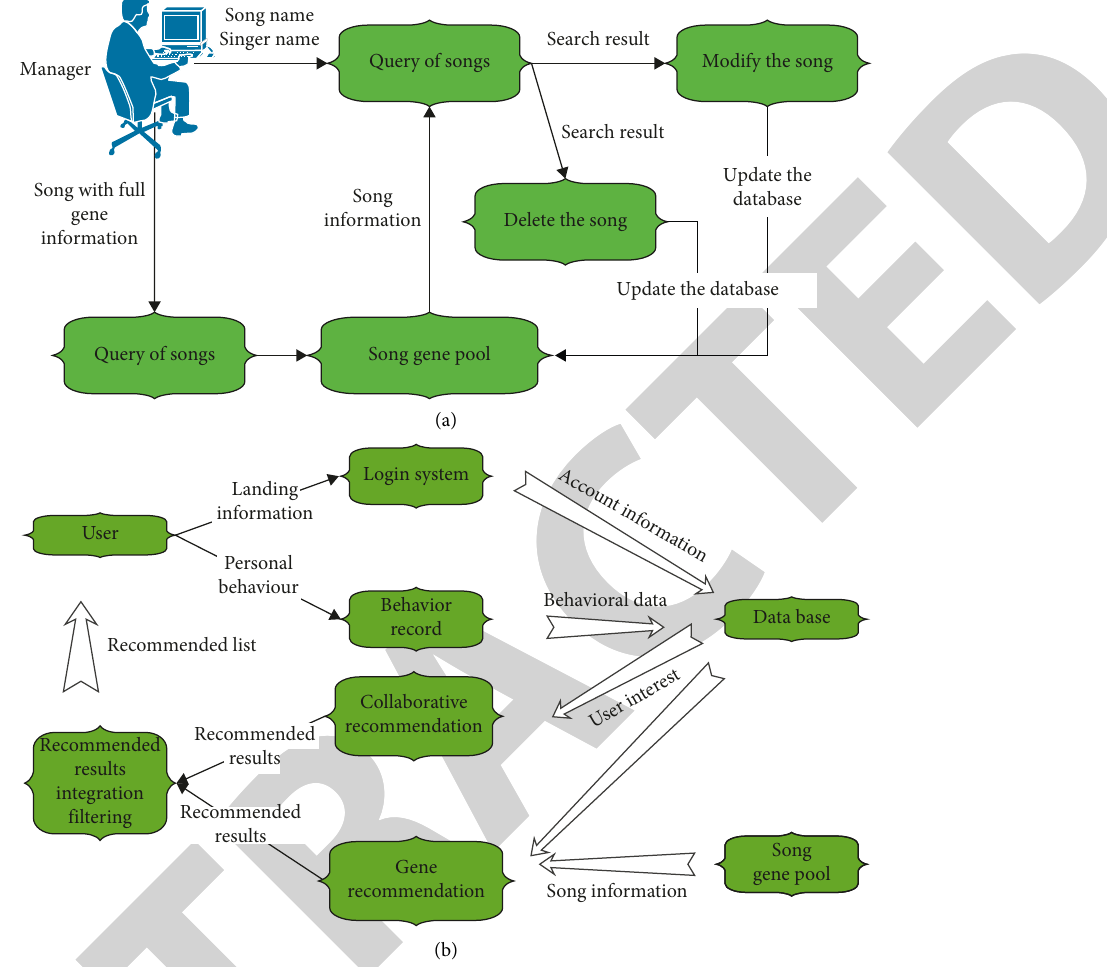
Figure 6: Data flow diagram of hybrid music recommendation based on music genes, (a) background management database, and (b) music recommendation data flow diagram.